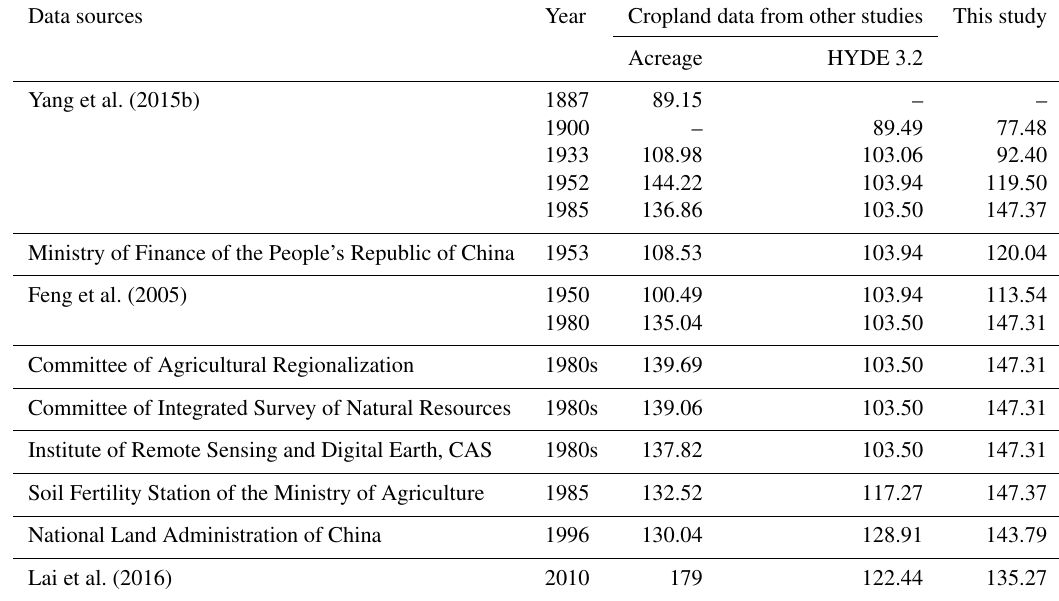
Table 3. Estimates of total cropland area (million hectares) in China from this study, HYDE 3.2, and other